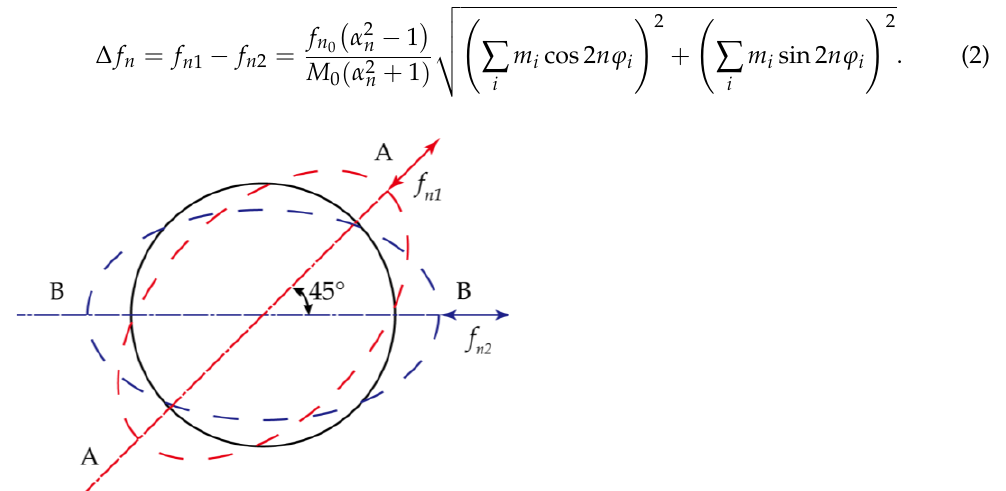
Figure 1. The ring with unbalanced mass.